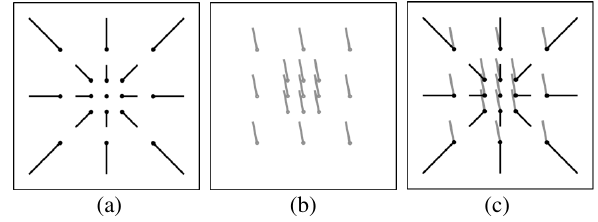
Figure 7. Exemplary depiction of the view of (a) poles in an aerial image acquired in nadir direction, (b) the corresponding shadows and (c) both combined